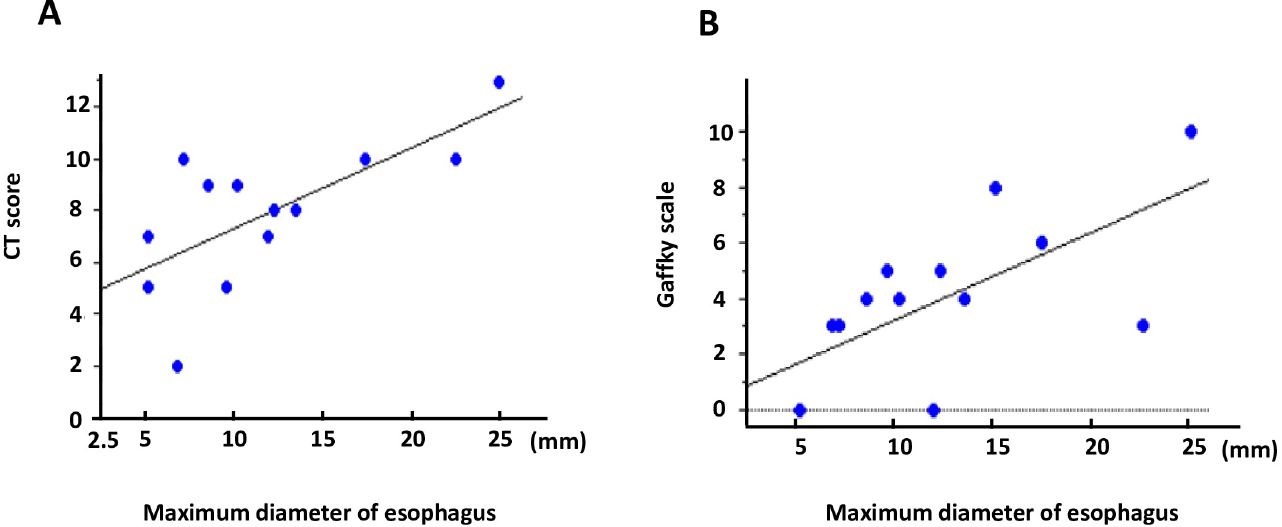
Fig 1. Correlation of CT score(A), gaffkey score (B) and maximum diameter of esophagus (MDE) Correlation of CT score and maximum diameter of esophagus (MDE) is shown in A. Correlation of gaffky score and MDE is shown in